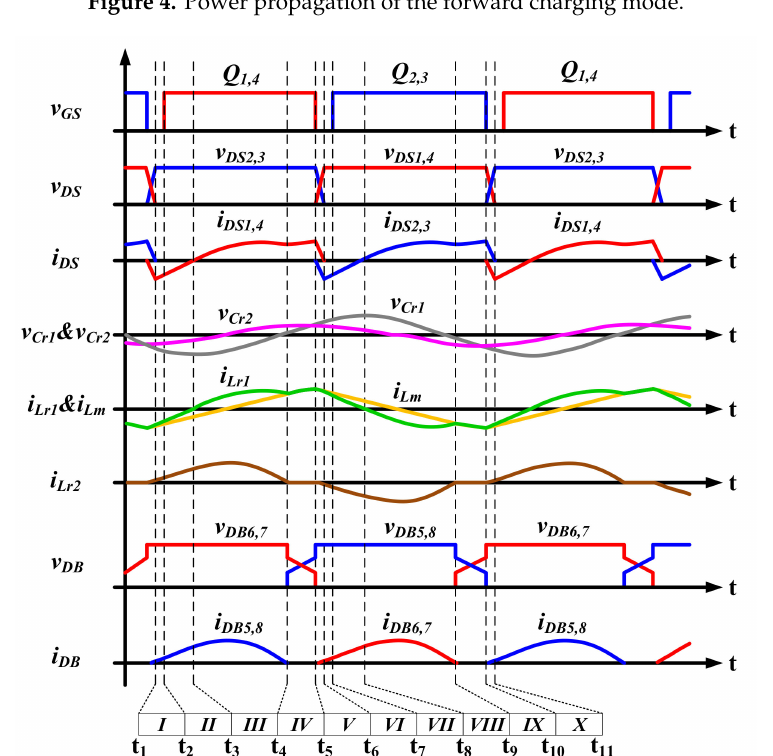
Figure 5. Important theoretic waveforms operating in Region